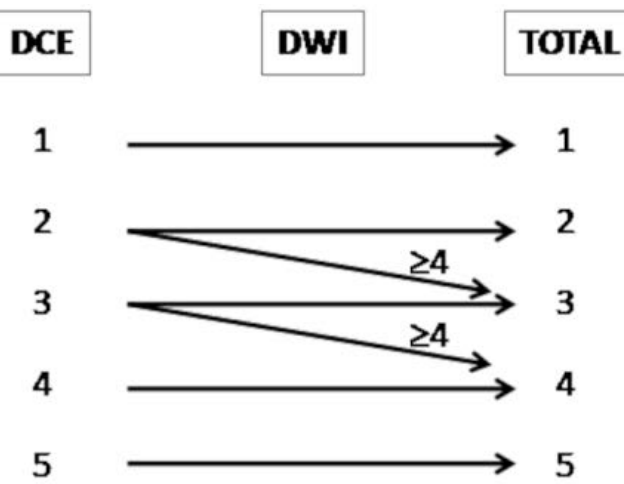
Figure 1. PI-RR score assessment.